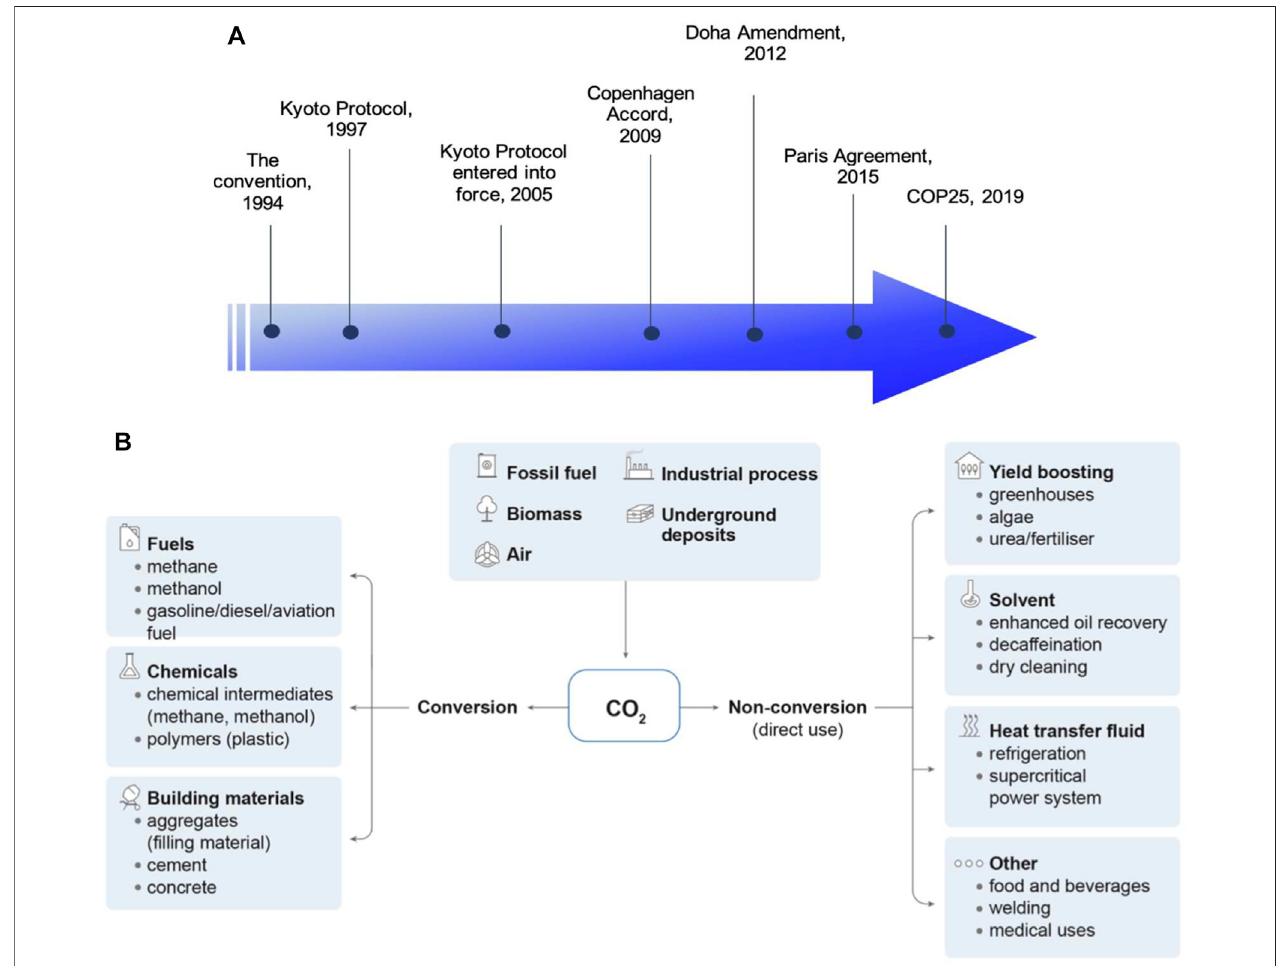
FIGURE 1 | (A) Timeline of major UNFCCC actions on climate change. (B) Potential pathways for CO 2 utilization (IEA, 2019).